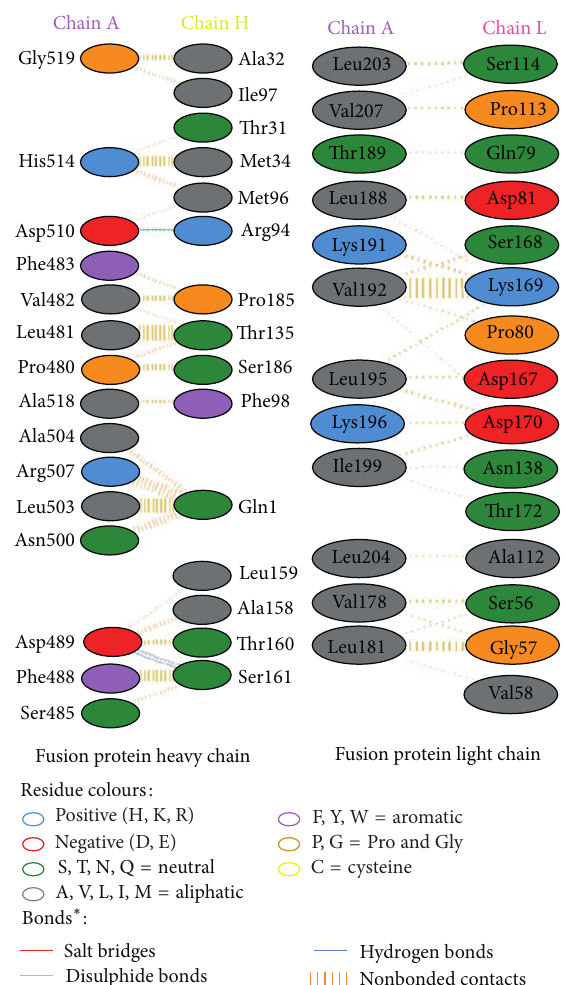
Figure 5: Interaction of fusion protein and motavizumab showing interaction of residues with heavy and light chain through various bonds ∗ .